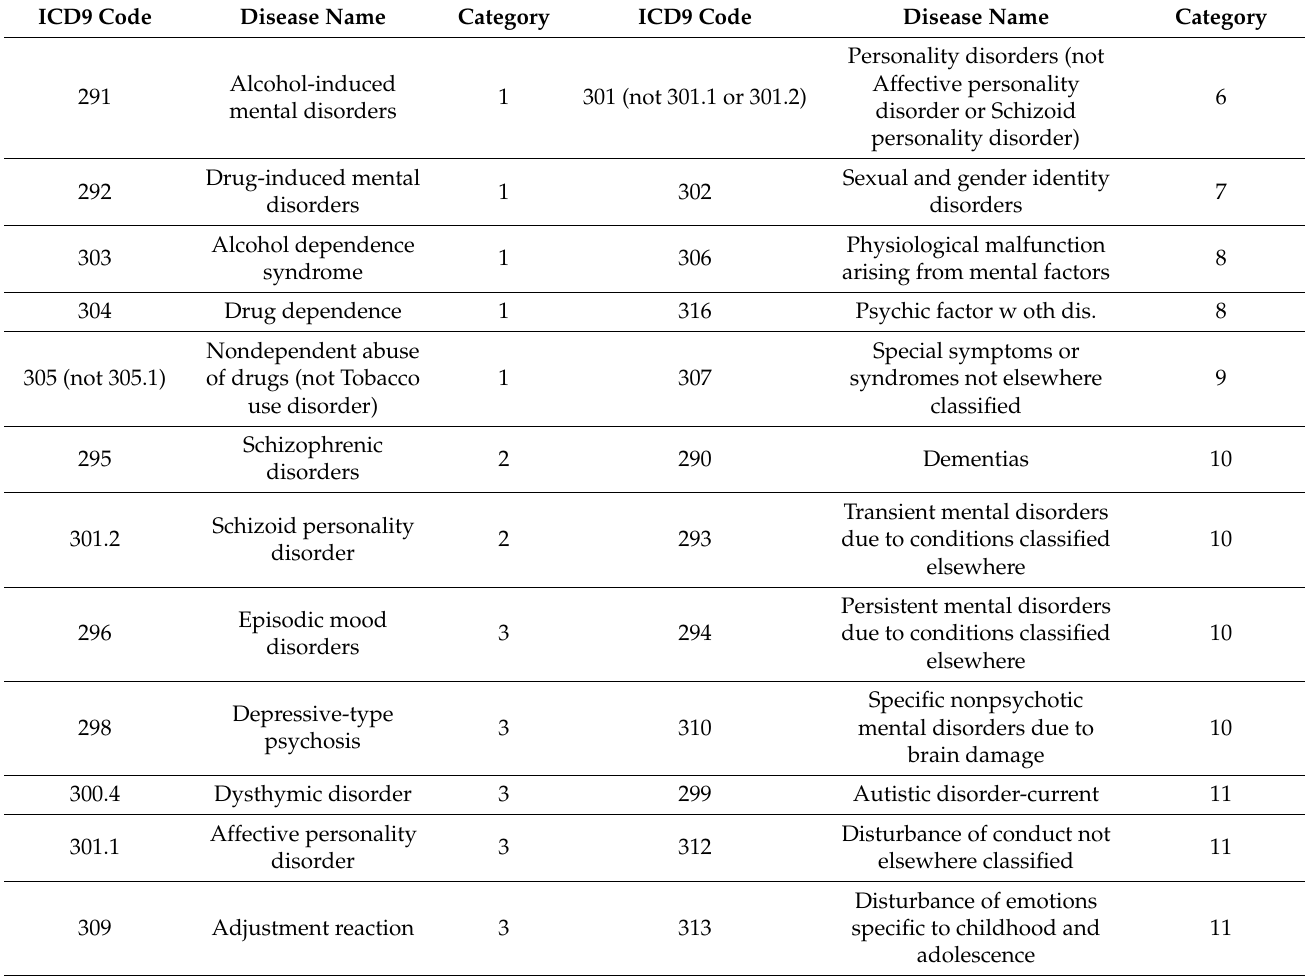
Table A1. Categories of Comorbid Diseases (from Michael Sanderson’s Work